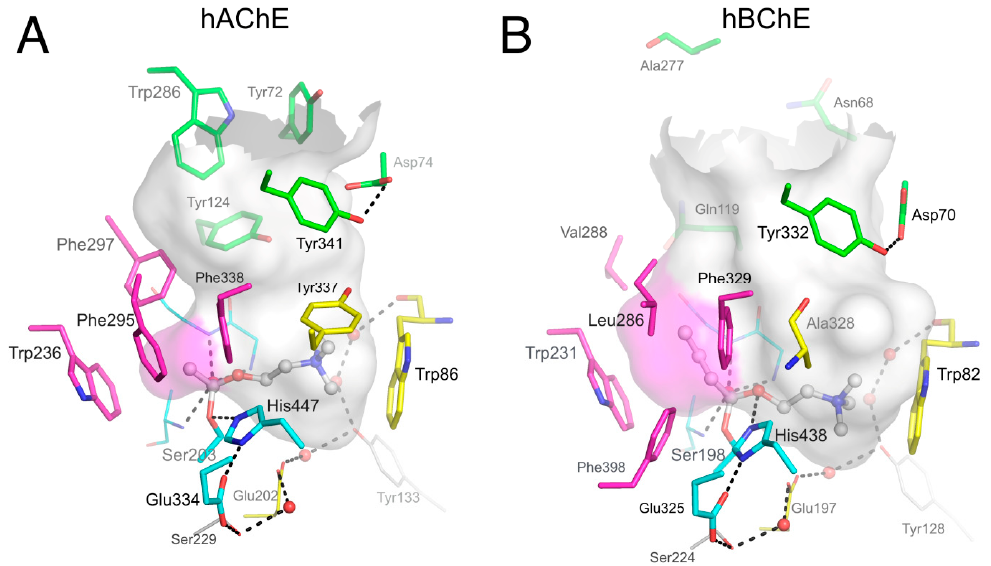
Figure 1. Active site gorges of human acetylcholinesterase (hAChE) ( A ; pdb 4ey4) and human butyrylcholinesterase (hBChE) ( B ; pdb 1p0i). The acylation transition state of a substrate molecule of acetylcholine (ACh) or butyrylcholine (BCh) is modelled and represented in ball and stick. The gorge is depicted by its molecular surface (semi-transparent gray and magenta for the acyl-binding pocket). The main residues are represented. The catalytic triad (in sticks) and oxyanion hole residues (in lines) of the A-site are in cyan. The acyl-binding pocket of both enzymes is in magenta. The key aromatic residues of the choline-binding pocket in the A-site are in yellow. P-site residues located at the rim of the gorge are in green. Conserved structural water molecules are represented in red spheres. The dense hydrogen bond network of the A-site is represented in dashed lines.